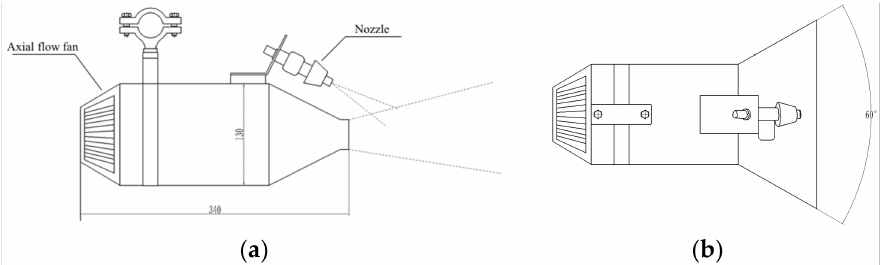
Figure 1. Structure of the air-assisted spray unit: ( a ) side view of the air-assisted spray unit; ( b ) top view of the air-assisted spray